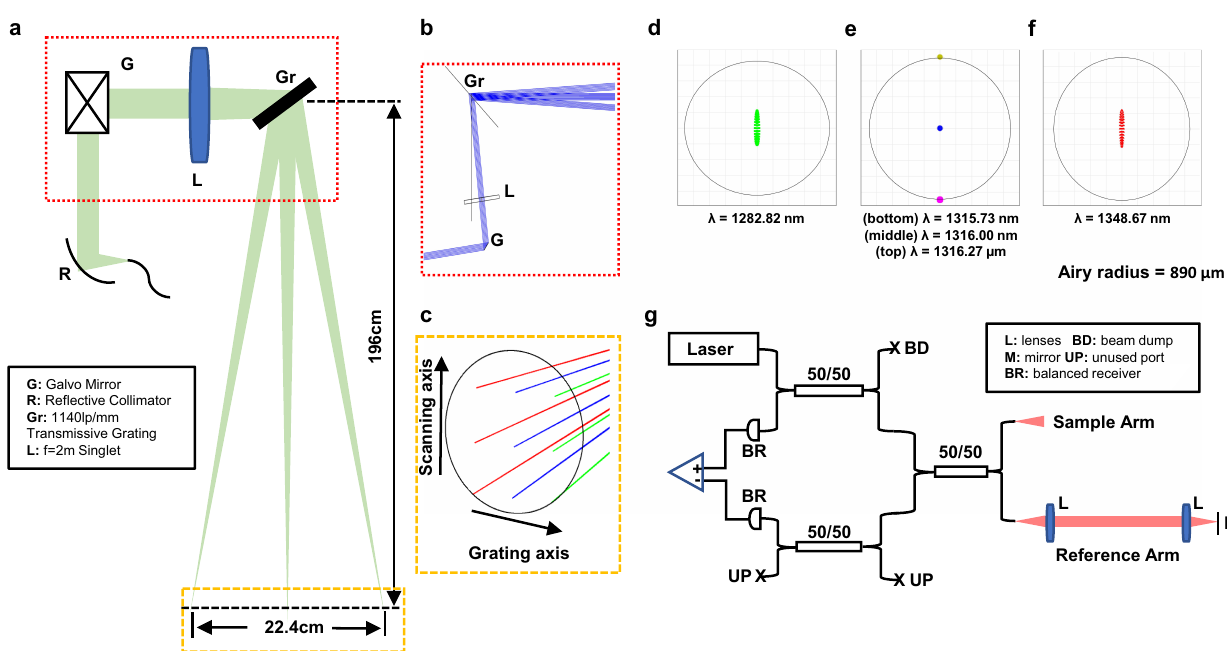
Fig. 1 Optical and system design of the real-time time-frequency multiplexed FMCW LiDAR system. a Schematic of the sample arm optical design and b , c corresponding zoomed-in Zemax design; d – f Spot diagrams at the imaging plane of the d fi rst, e central, and f last wavelengths, along with e two wavelengths that have centroids of spots located adjacent to the central wavelength with a separation distance of the Airy radius at the focus; g Schematic of the overall system three factors: the coherence length or instantaneous linewidth of the swept laser, the maximum sampling speed of the digitizer, and the bandwidth of the photodetector. In our current setup, the maximum imaging range without signi fi cant sensitivity roll-off was approximately 32 cm, limited by both the sampling speed of the digitization card (800MS/s) and the bandwidth of the pho- todetector (400 MHz).